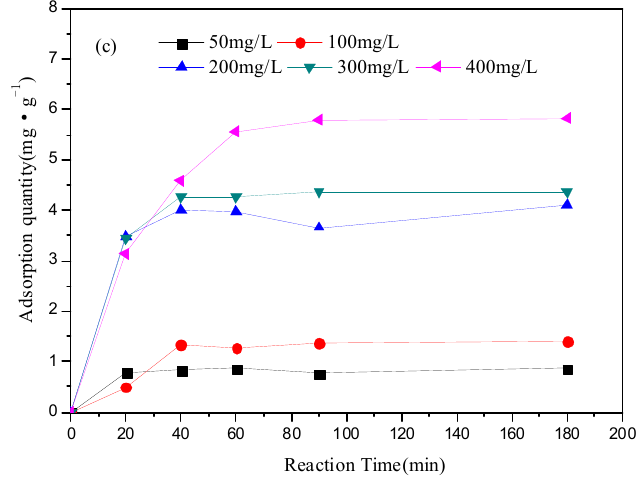
Figure 1. Effect of initial concentration of Fe 3+ on adsorption capacity of the three layers of soil: ( a ) top layer of loess soils; ( b ) core layer of loess soils and ( c ) subsoil layer of loess soils. (4 mg of soil, pH = 4.20, 25 °C).